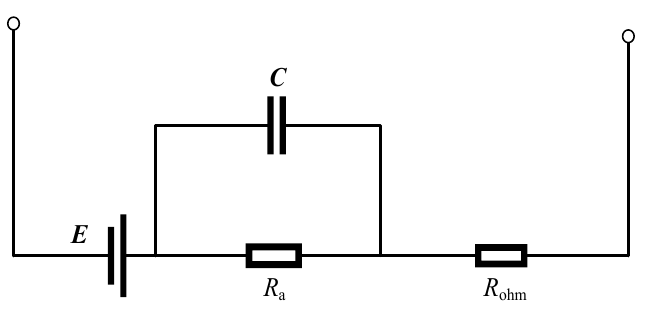
Figure 3. Equivalent circuit model of PEMFC.